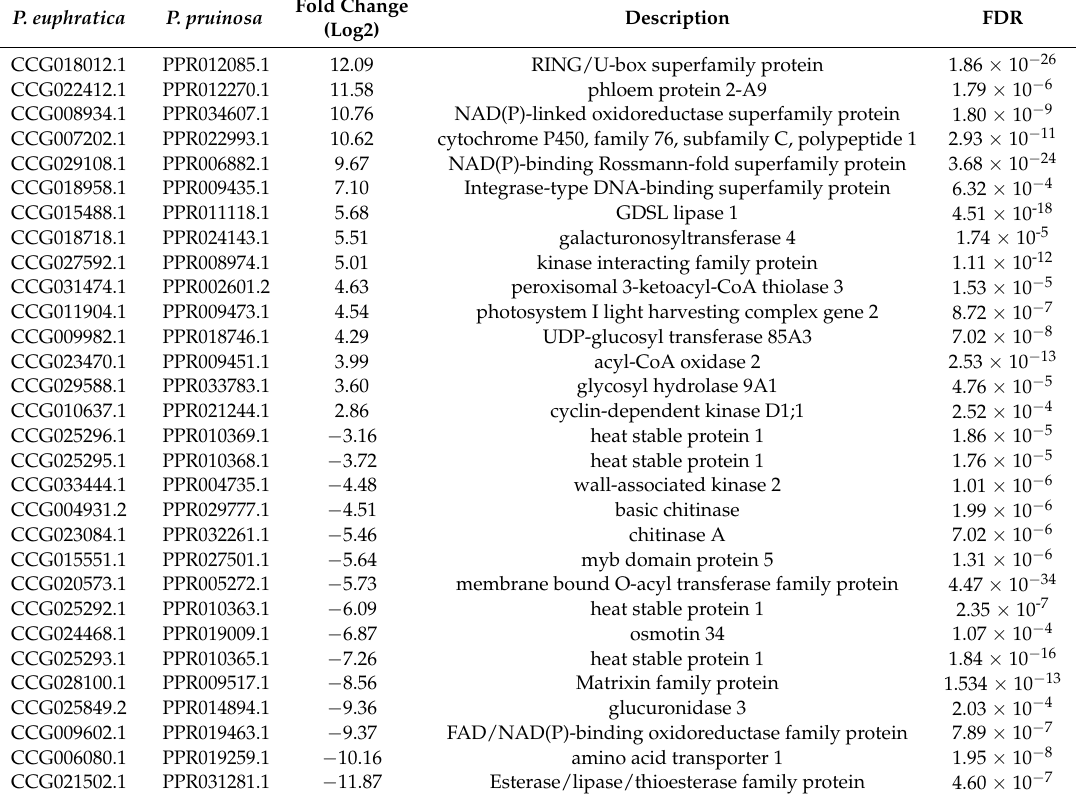
Table 1. List of 30 differentially expressed genes (DEGs) between two poplar